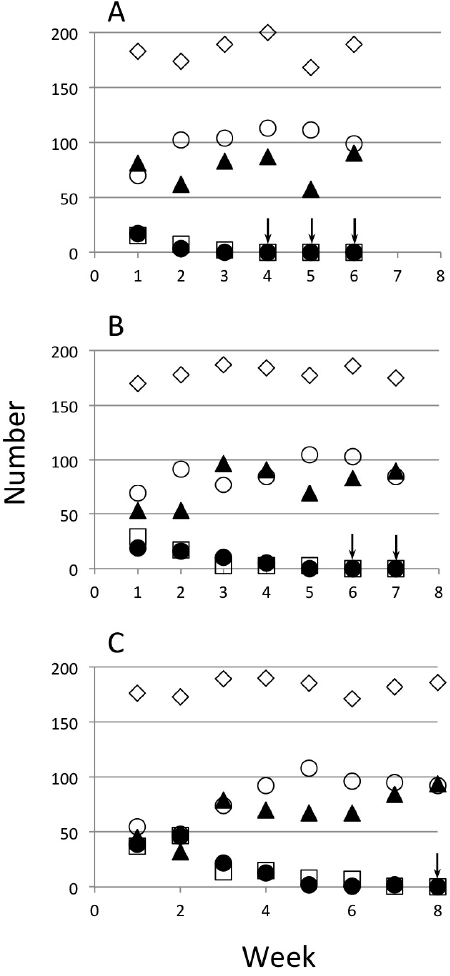
Figure 3. Restocking of Ag(DSM)1 cages. The actual numbers of pupae returned each week and the totals are represented. Three frequencies of seeding of hemizygous transgenic females were made: 20%, 50%, and 100% ( A – C , respectively). Transgenic males ( ● ), transgenic females ( ☐ ), non-trangenic males ( ▲ ), non-transgenic females ( ○ ), and the total ( ◇ ). Arrows indicate weeks in which no GM mosquitoes were detected.